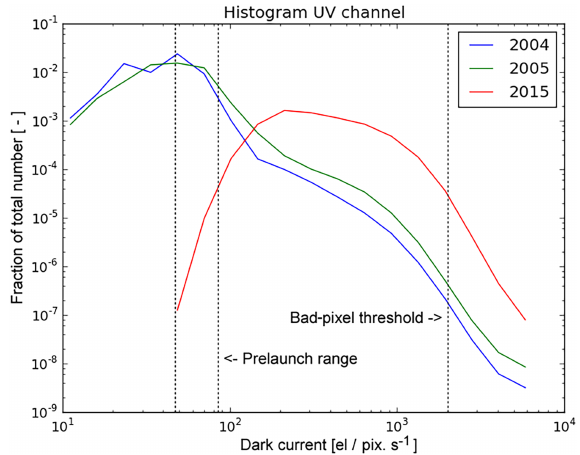
Figure 13. Histograms of dark current measured in the UV